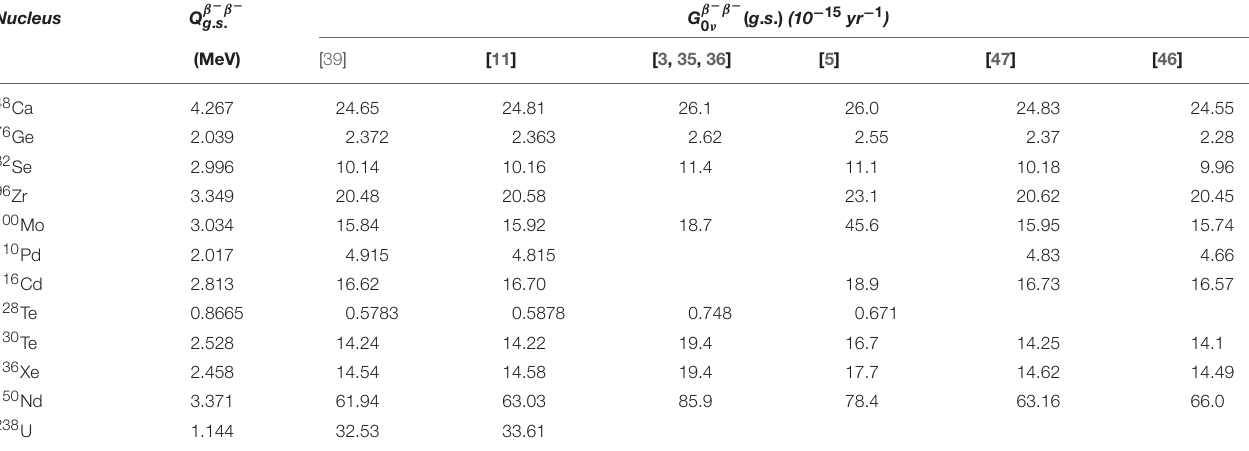
TABLE 2 | PSF for 0 νβ − β − decays to final g.s. Nucleus